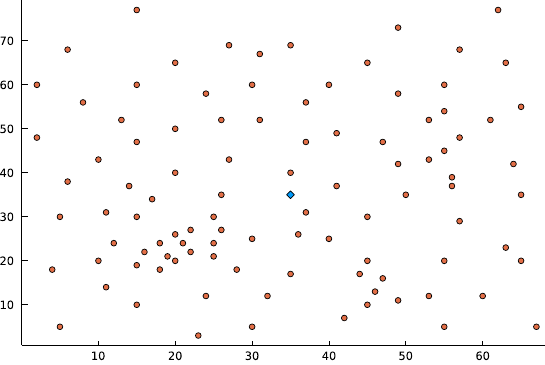
Figure 2. Distribution of customers (represented by circles) in R-instances with diamond representing the center.